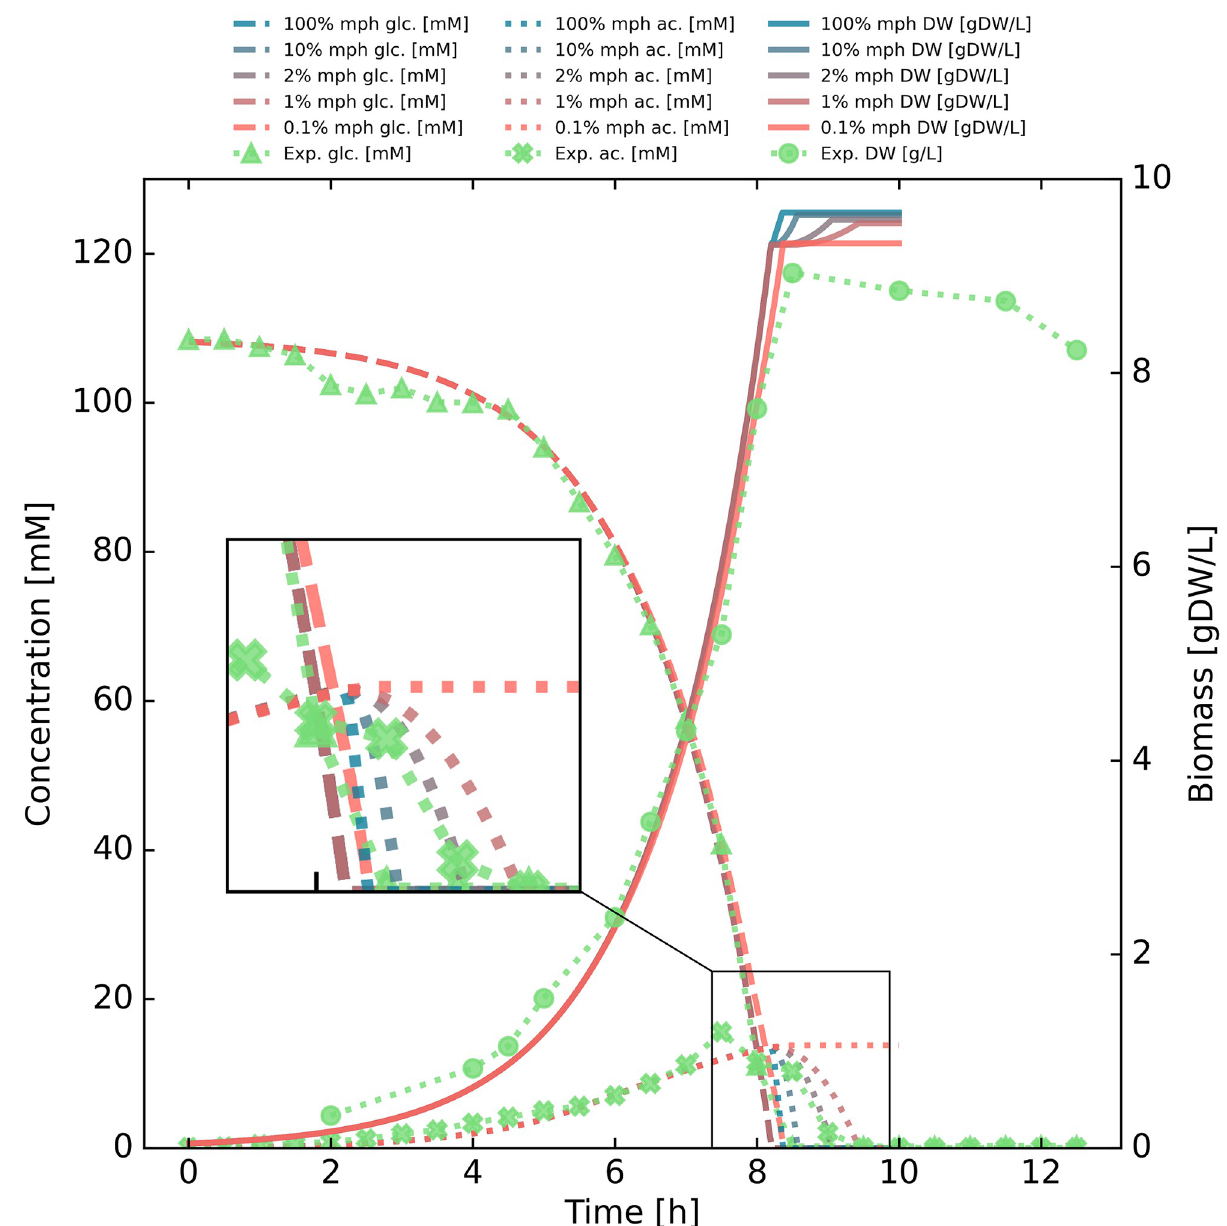
Fig 3. Enzyme composition change rate adjustment. Shown in the figure are glucose (glc), acetate (ac) and biomass concentrations (DW) for a range of ecc (enzyme change constraint) parameter values. It showcases a comparison of modeling results with experimental measurements when varying constraints on rate of change of enzyme composition. The rate is given as percentage of total cell mass (not enzyme mass) per hour (denoted mph in the legend) that can be reallocated. The rate of change of enzyme composition has a dramatic effect on the transient behavior of the model during diauxic growth, and a rate of 2% mph appears to best match the data measured from the fermentation experiment. The difference in terminal biomass is caused by the non-growth-associated maintenance (NGAM) function, which forces hydrolysis of ATP at a rate of 3.15 mmol gCDW − 1 h − 1